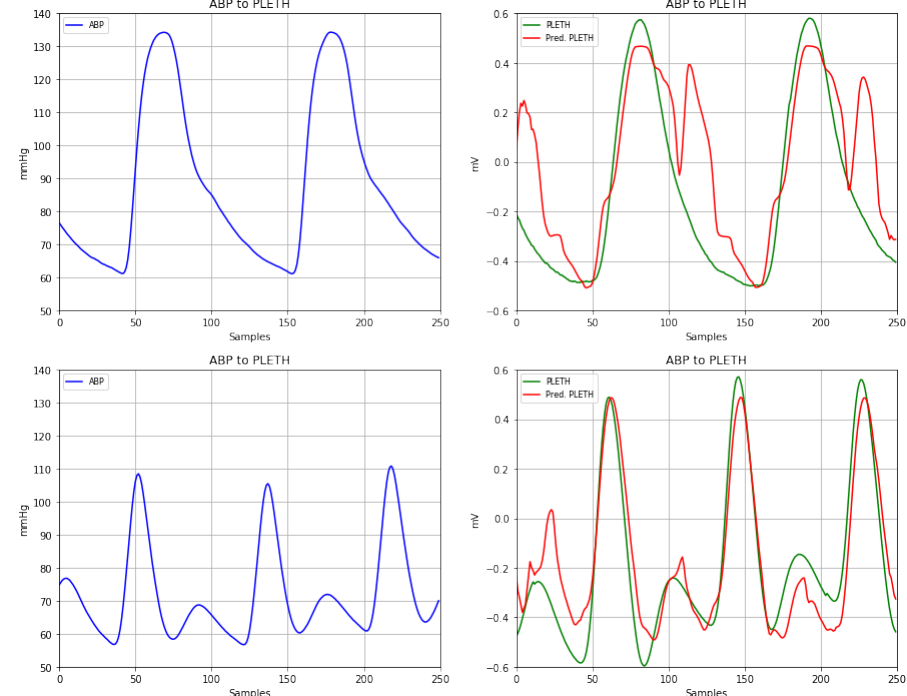
Figure 4. Two records (one in each row) with input signal (ABP) on the left, and output signal (predicted PLETH) and ground true signal (PLETH) on the right, for the ABP to PLETH